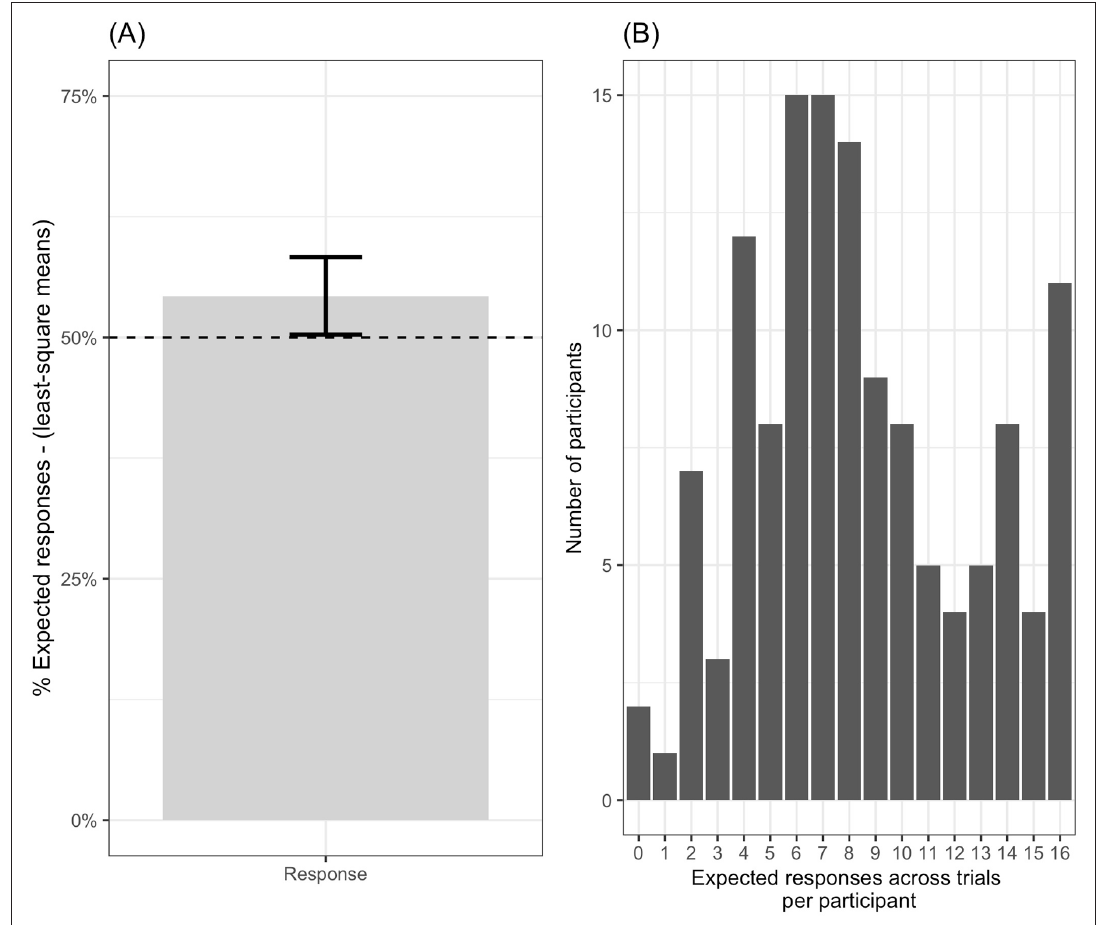
Figure 4: Estimated rate of expected responses according to our hypothesis in Experiment 2 with error bars representing standard errors (A) and Distribution of the number of expected responses per participant